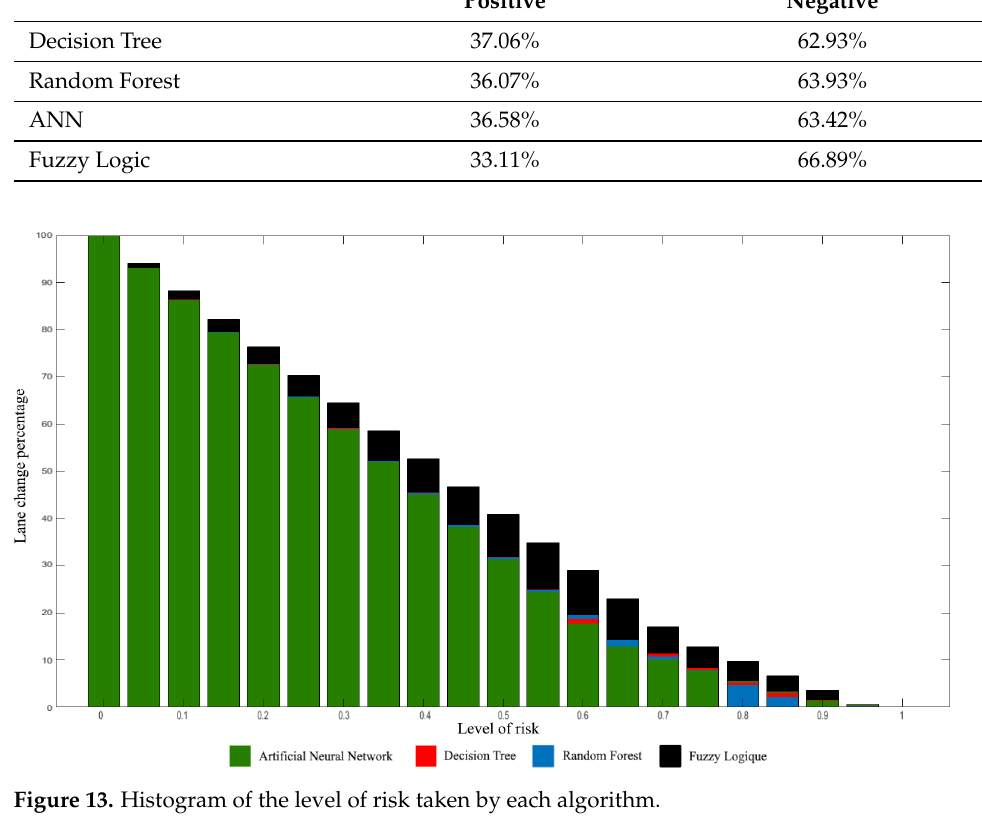
Figure 13. Histogram of the level of risk taken by each